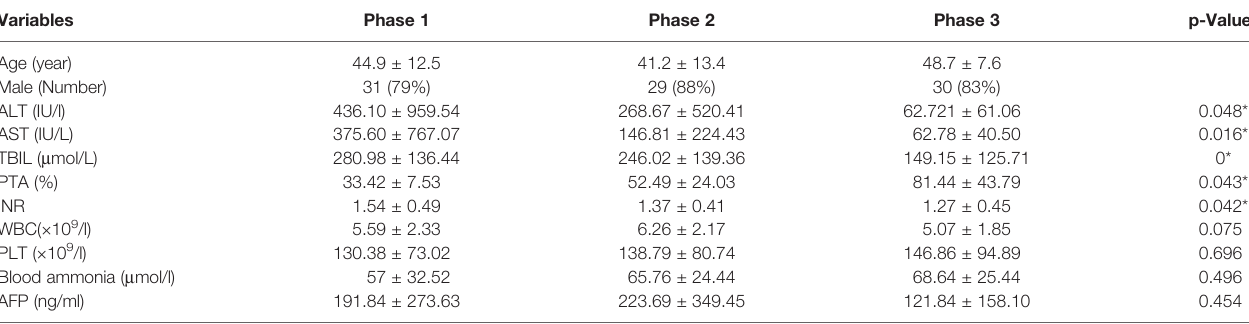
TABLE 1 | Clinical characteristics and of the subjects in this